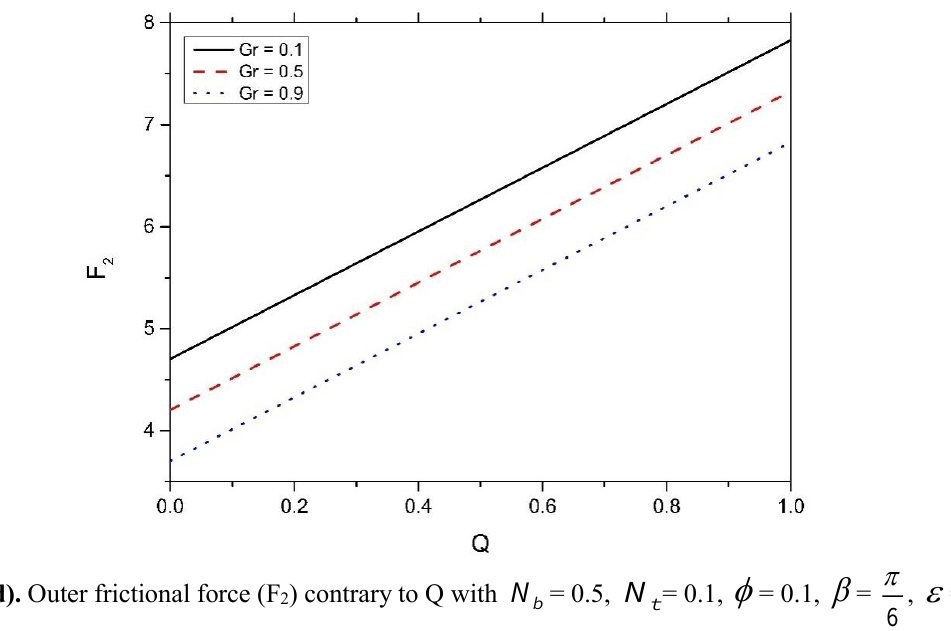
Br=0.3, F = 0.1, z = 0.5,